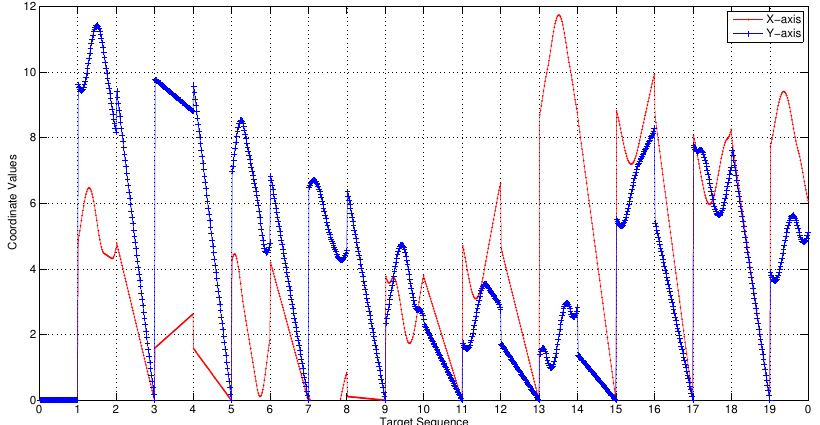
Figure 10. G 0 continuity in the X − Y coordinates for the AA-3DTSP algorithm. The Z -axis continuity